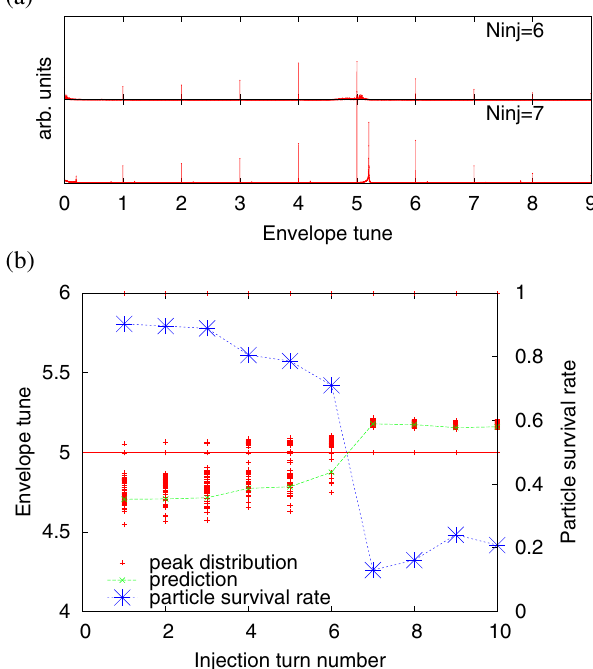
FIG. 7. (a) FFT spectra with six-turn injection and seven-turn injection. (b) Peak distribution and the particle survival rate with different injection turn numbers ( Δ K 1 L ¼ 0 . 01 m − 1